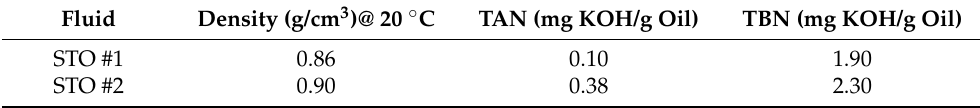
Table 2. Total acid number (TAN), total base number (TBN), and density of the stock tank oils (STO).